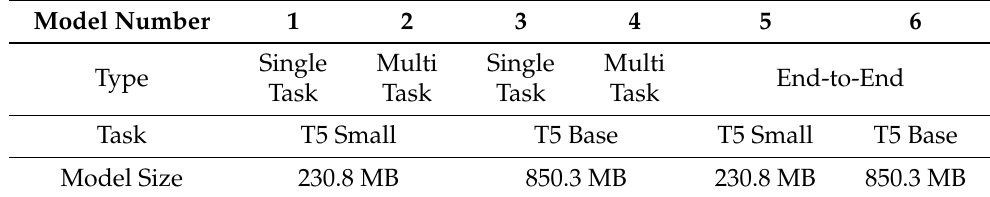
Table 1. The Neural Question Generation Models in Ensemble-NQG-T5.